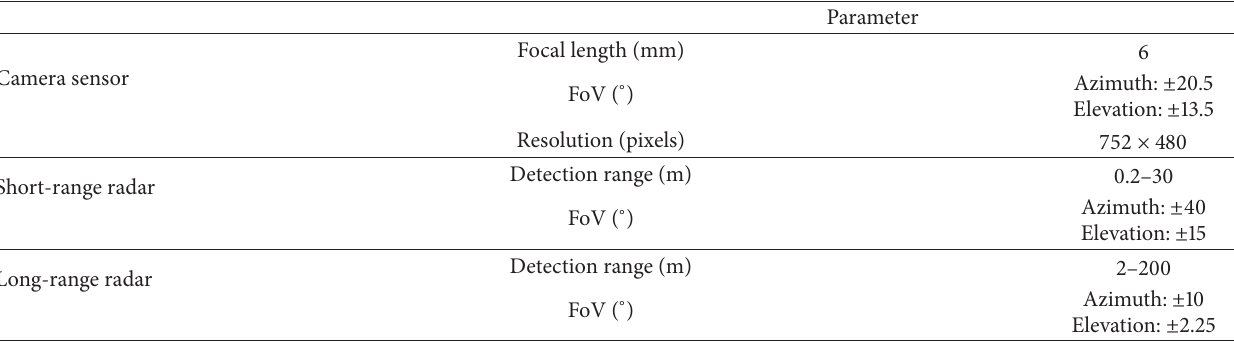
Table 2: Vehicle-mounted sensors’ specifications.